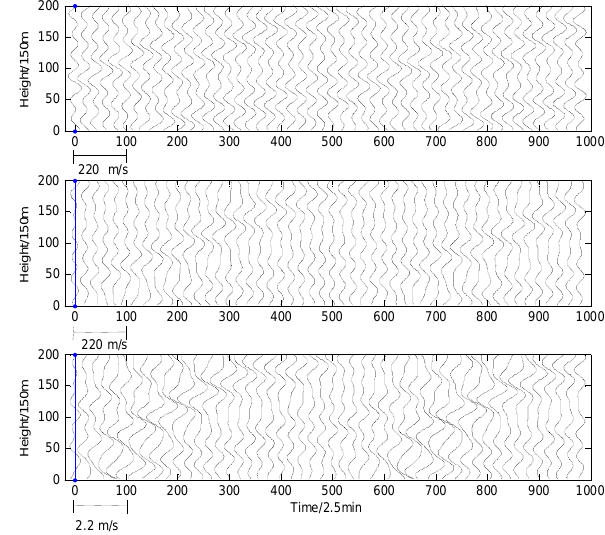
Fig. 6b. Height variations of perturbation velocities at successive Fig.6b Height variations of perturbation velocities at successive times. Top panel : zonal times. Top panel: zonal velocity profile; middle panel: merid- velocity profile; Middle panel: meridional velocity profile; Bottom panel: vertical ional velocity profile; bottom panel: vertical velocity profile. The velocity profile. The time step is 2.5 minutes and the height resolution is 150 meters. time step is 2.5min and the height resolution is 150m. The The data were obtained from equations (7a,b,c) and Table 2a with data were obtained from Eqs. (7a), (7b), (7c) and Table 2a with ( , , , , ) (0.1,0.1,0.1,0.1,0.1) A A A A A = . The vertical lines indicated 0 m/s for the first 10 (A 1 ,A 2 ,A 3 ,A 4 ,A 5 ) = ( 0 . 1 , 0 . 1 , 0 . 1 , 0 . 1 , 0 . 1 ) . The vertical lines in- 1 2 3 4 5 dicated 0ms − 1 for the first profile, and successive profiles are profile, and successive profiles are 50 minutes apart. The velocity scales are indicated 50min apart. The velocity scales are indicated at the bottom of at the bottom of each panel. These velocity profiles were prepared for hodograph each panel.. These velocity profiles were prepared for hodograph analysis. analysis.